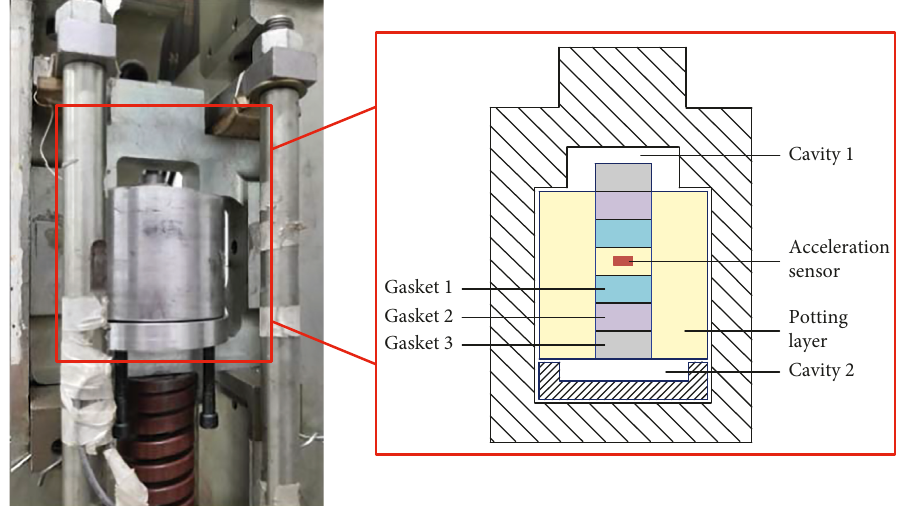
Figure 8: Experimental fixture and assembly relationship.